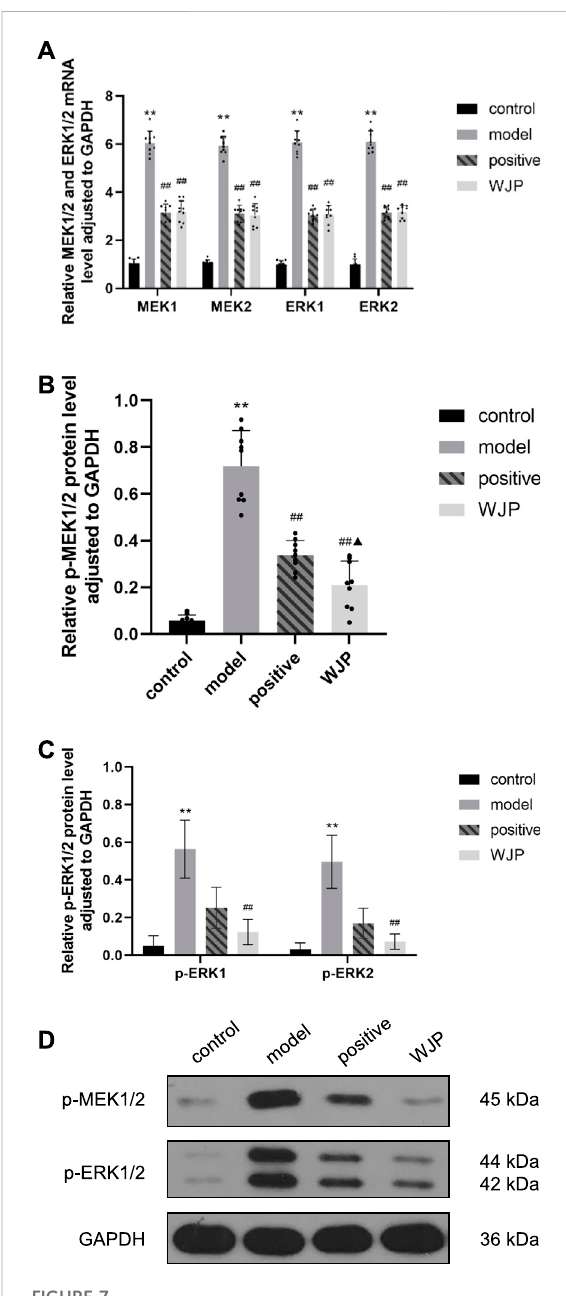
FIGURE 8 Effect of WJP on the relative expression of mRNA of MEK1, MEK2, ERK1, and ERK2 and the relative expression of protein of p-MEK1/2, p-ERK1, and p-ERK2 in the hippocampus in the four groups. (A) The relative expression of mRNA of MEK1, MEK2, ERK1, and ERK2. (B) Therelativeexpressionofproteinofp-MEK1/2. (C) Therelativeexpression of protein of p-ERK1 and p-ERK2. (D) Western blot analysis. * p < 0.05; ** p < 0.01, versus the control group. # p < 0.05; ## p < 0.01, versus